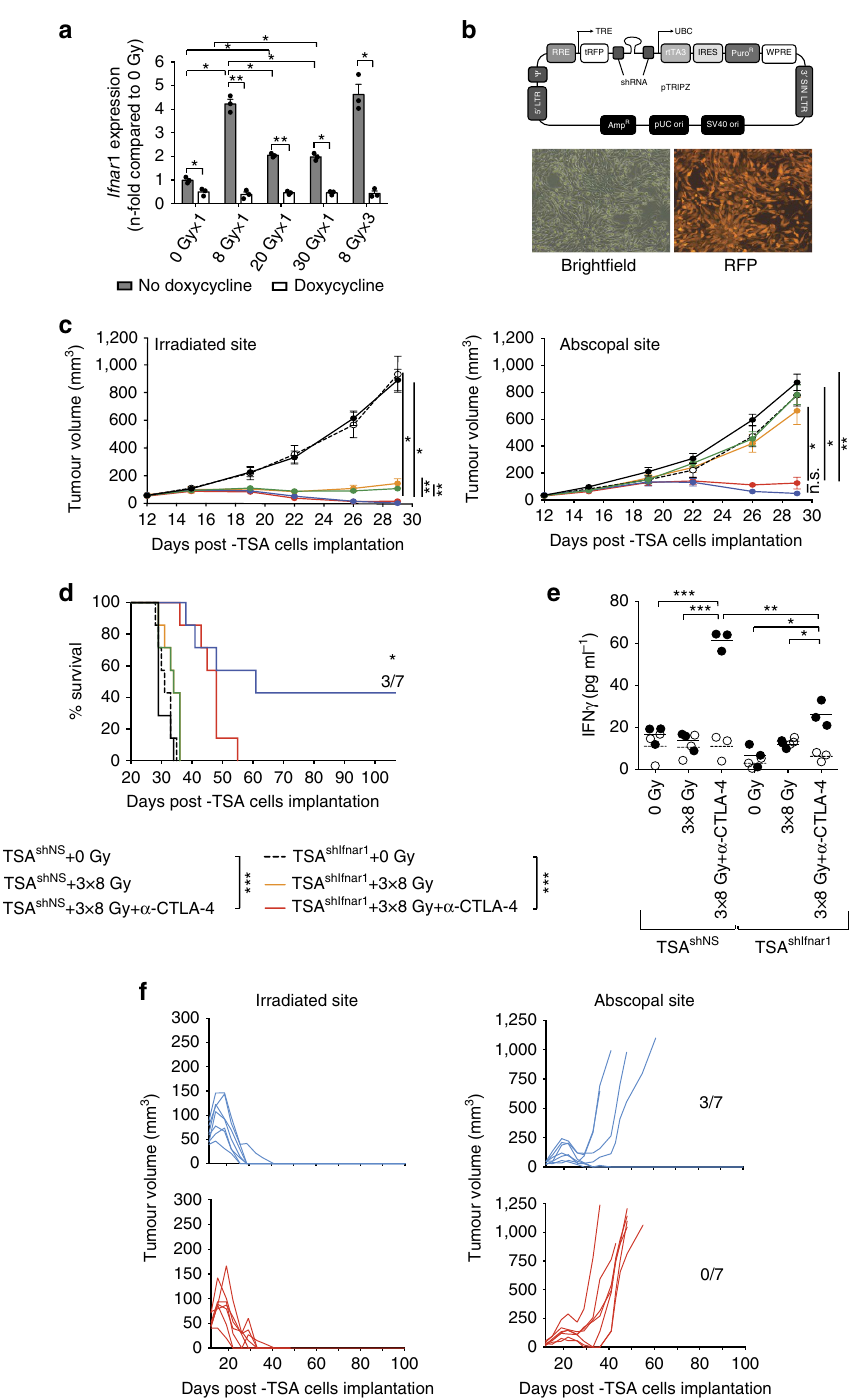
Figure 2 | IFNAR1 expression by TSA cancer cells is required for optimal therapeutic response of mice treated with 8GyX3 and anti-CTLA4. ( a ) Upregulation of Ifnar1 expression measured by qRT-PCR 24 h after radiation in vitro in tetracycline-treated TSA shNS cells (black bars) is abrogated in TSA shIfnar1 cells (white bars) (Duplicate; * P o 0.05; ** P o 0.005; *** P o 0.0005: t -test; n ¼ 3). ( b ) pTRIPZ lentiviral vector with tetracycline-inducible shRNA and TurboRFP fluorescent protein (tRFP) expression, and microscopic image of tetracycline-treated TSA shNS cells (magnification ¼ (cid:3) 20). ( c – f ) Mice bearing irradiated TSA shIfnar1 or TSA shNS tumours and TSA shNS tumours in the abscopal site were treated with tetracycline and 0Gy (TSA shNS ¼ black; TSA shIfnar1 ¼ dashed line), 8GyX3 (TSA shNS ¼ green; TSA shIfnar1 ¼ yellow), 8GyX3 þ anti-CTLA4 (TSA shNS ¼ blue; TSA shIfnar1 ¼ red). ( c ) Growth of irradiated and abscopal tumours. Duplicate; * P o 0.05; ** P o 0.005: comparison of irradiated tumour outgrowth; two-way ANOVA; n ¼ 7. ( d ) Survival. Numbers indicates fraction of tumour-free mice. Log-rank (Mantel–Cox) test for the survival experiment; n ¼ 7 ( e ) IFN g production by tumour-draining lymph node (TDLN) cells in response to the CD8 Tcell epitopes AH1A5 (full circles) or control peptide MCMV (open circles). Each symbol represents one animal. Horizontal lines indicate the mean of antigen-specific (solid lines) or control (dashed lines) IFN g concentration. Duplicate; * P o 0.05; ** P o 0.005; *** P o 0.0005: t -test; n ¼ 3 ( f ) Individual tumour growth from ( d ) showing recurrence of all abscopal tumours in mice bearing irradiated TSA shIfnar1 tumours (red) while 3/7 mice with irradiated TSA shNS tumours (blue) remained tumour-free. All data are mean ± s.e.m. NATURE COMMUNICATIONS|8:15618|DOI: